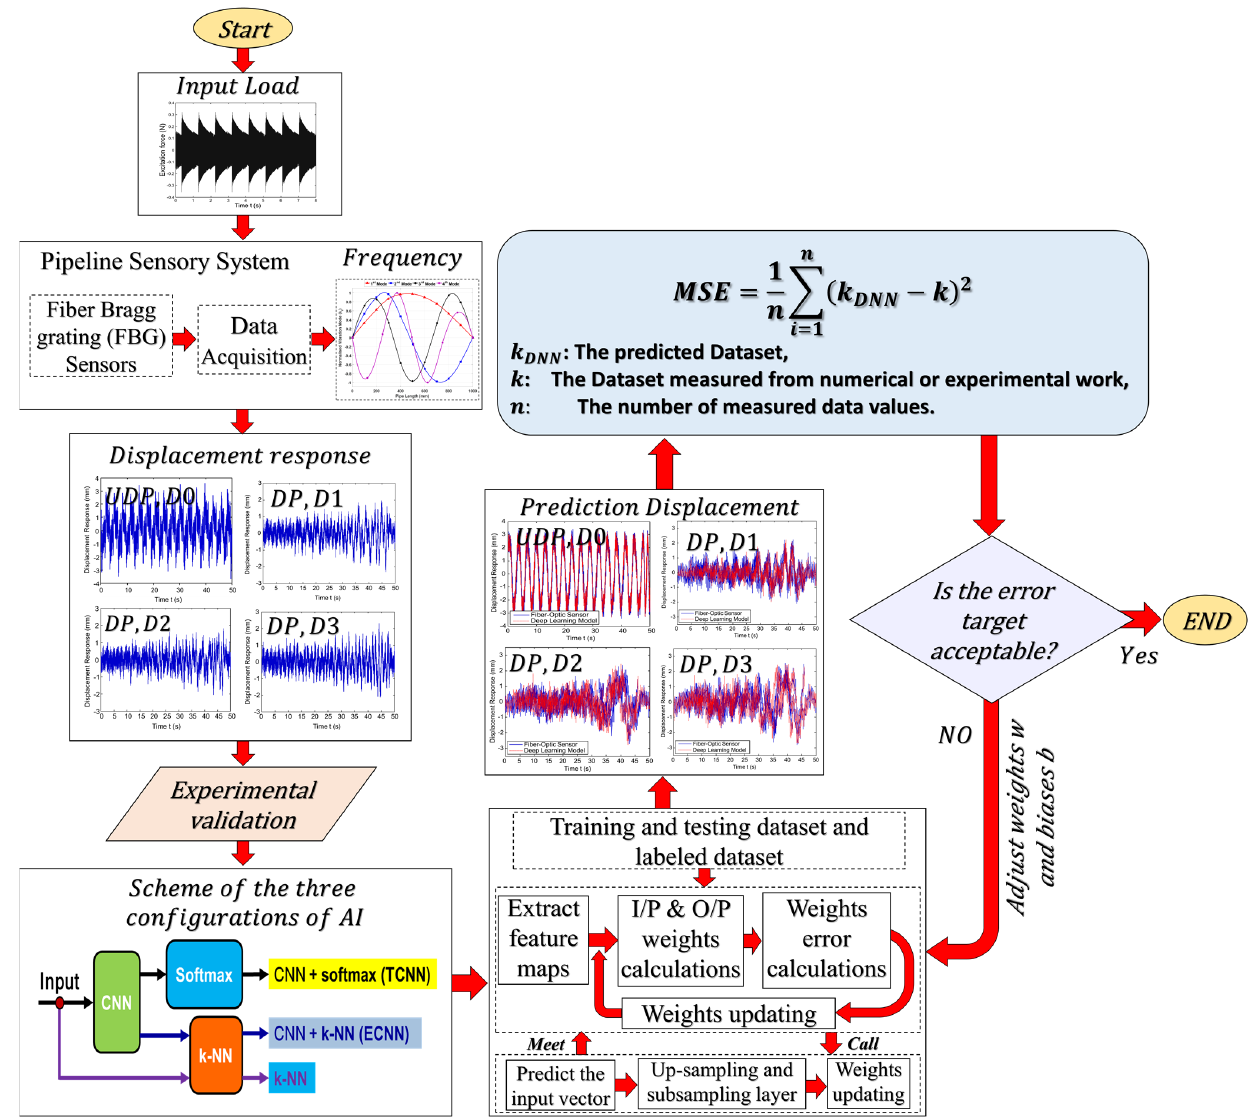
Figure 1. Methodology flowchart.